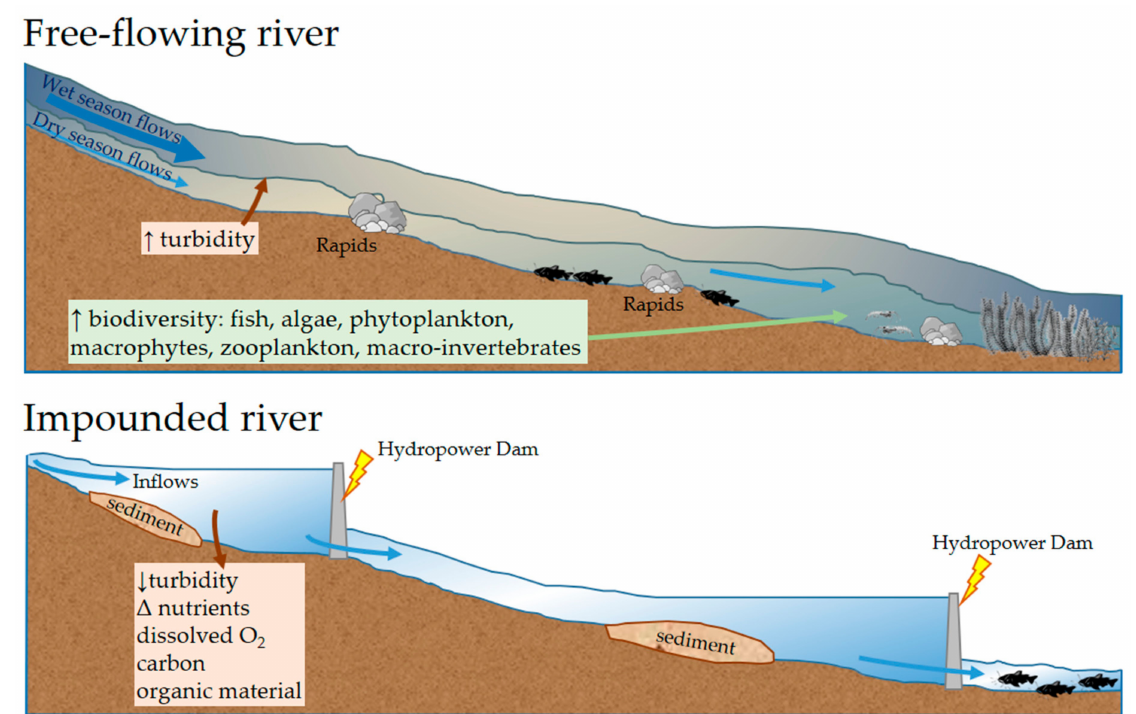
Figure 2. Conceptual model showing top: a free-flowing 3S river with a seasonal flood-pulse, high turbidity, high biodiversity, high productivity, and habitat that is connected longitudinally and laterally to floodplains and wetlands. Bottom: an impounded river with a cascade of hydropower dams that remove the seasonal flood-pulse, trap sediment, fragment and reduce habitat, block organism movement, and diminish biodiversity and productivity.